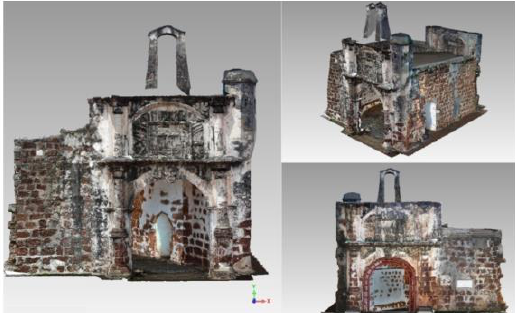
Figure 10. Multiple view of 3D photorealistic model of A'Famosa (external images)